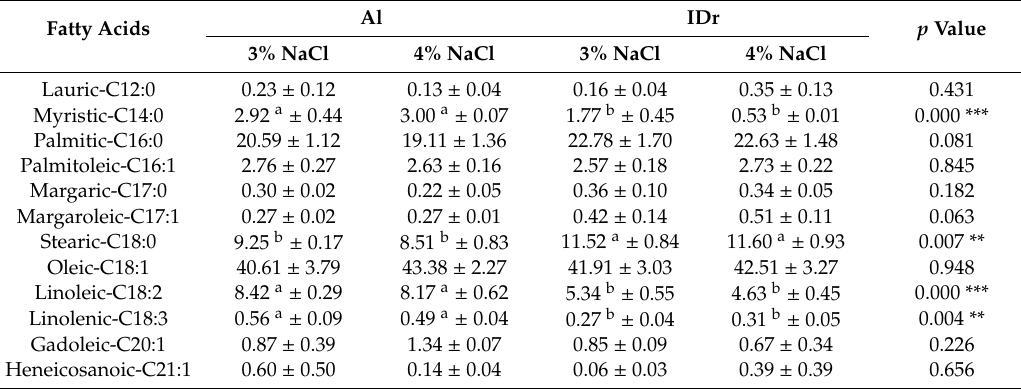
Table 2. Influence of pig genotype in methyl ester fatty acid-derivatives profile of Catal ã o